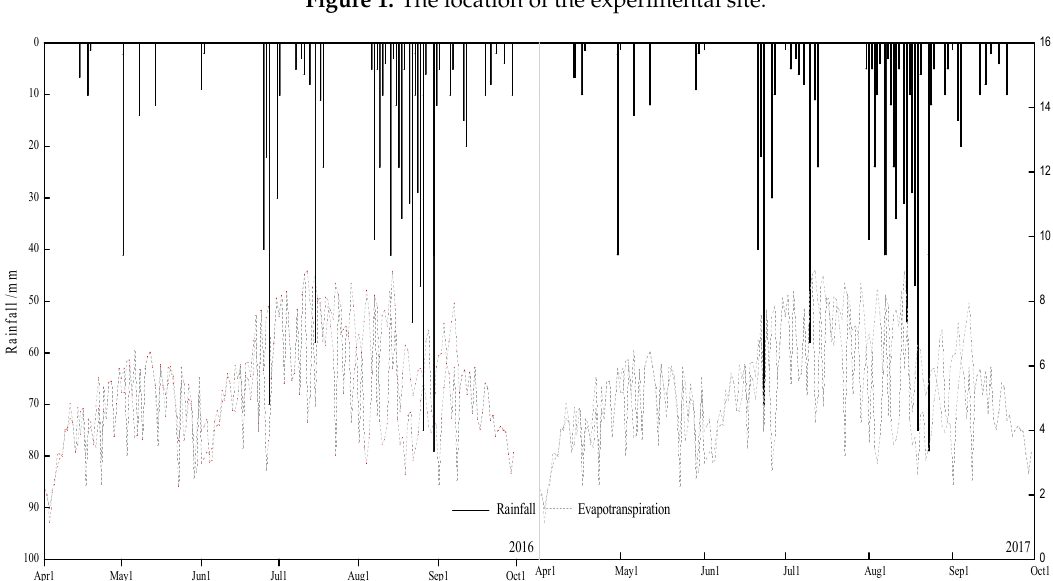
Figure 1. The location of the experimental site.